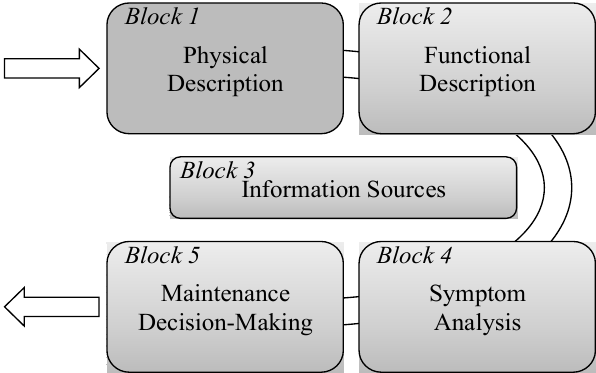
Figure 9. Processing blocks in the proposed framework Guillen et al., (2016). Reproduced from [34], Computers in Industry: 2016.